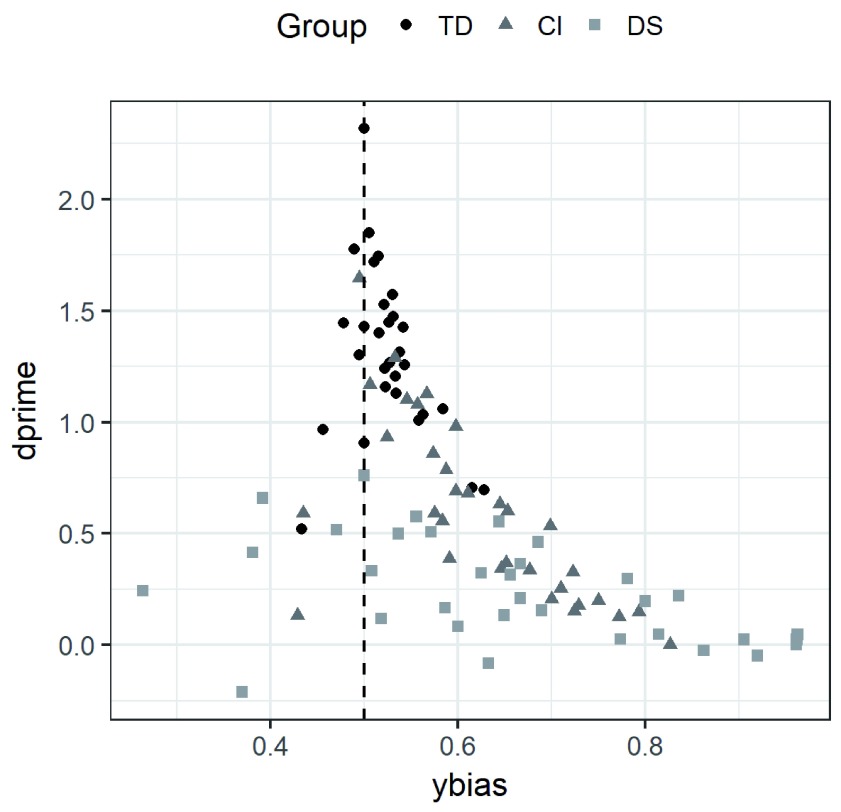
Plot of
d prime measure against the proportion of correct yes responses (ybias).